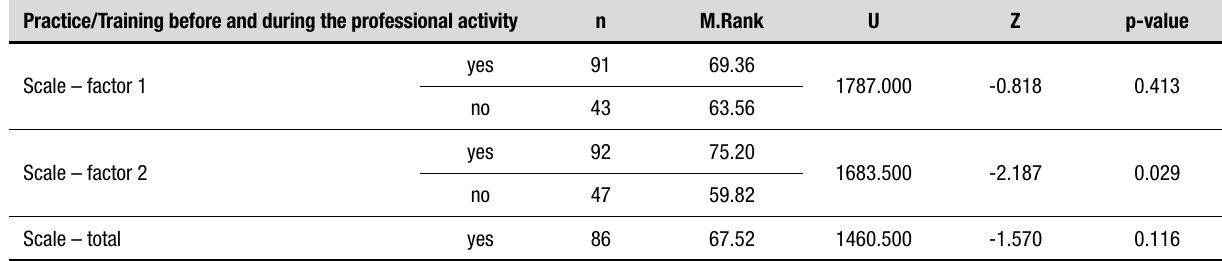
Table 5. Results of Mann-Whitney’s U test regarding training frequency during professional activity and practices. Lisbon, Portugal. Practice/Training before and during the professional